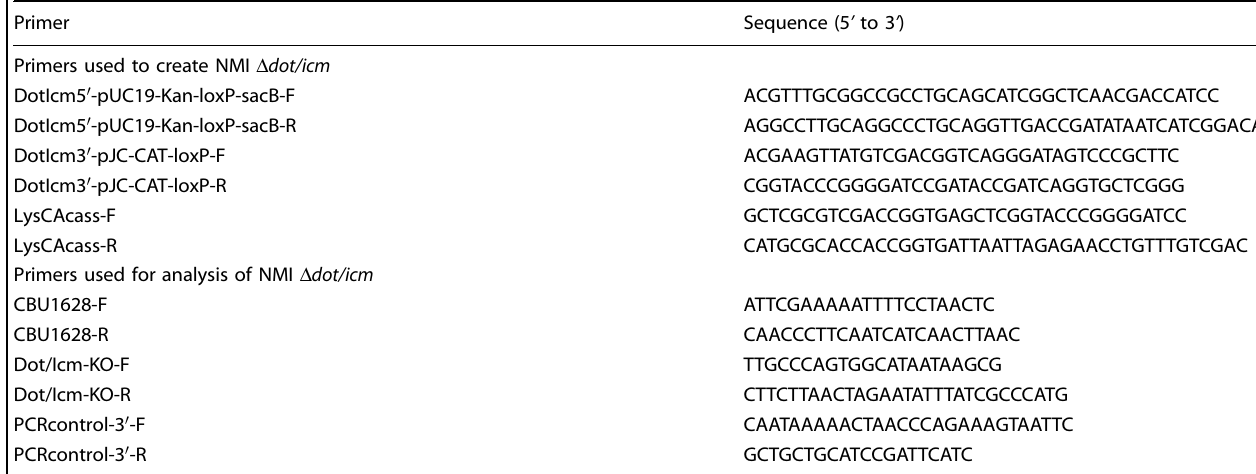
Table 3. Oligonucleotide primers used in this study. Primer Sequence (5 ’ to 3 ’ ) Primers used to create NMI Δ